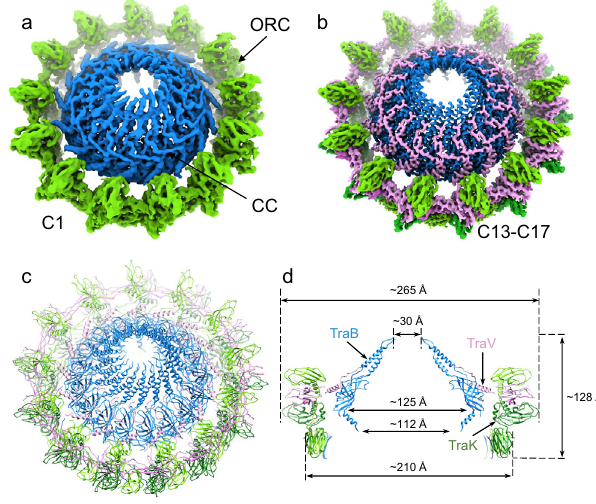
Fig. 1 Cryo-EM structure of the F-encoded OMCC. a Asymmetric reconstruction (C1) of the OMCC F at 4.22 Å (Supplementary Fig. 2). The C1 structure shows two distinct subassemblies, an outer ring complex (ORC) with 13-fold symmetry and a central cone (CC) with 17-fold symmetry. b A high-resolution map synthesized from the symmetrized ORC and CC maps. ORC is resolved to 3.31 Å with 13-fold symmetry imposed and the CC is at 2.95 Å resolution with 17-fold symmetry imposed (Supplementary Fig. 2). c The atomic models built from ( b ). d A central slice of the atomic model ( c ) with different sizes labeled. Subunit colors: TraK (Green), TraB (Blue), TraV (Pink). Structures of the C1, C13, and